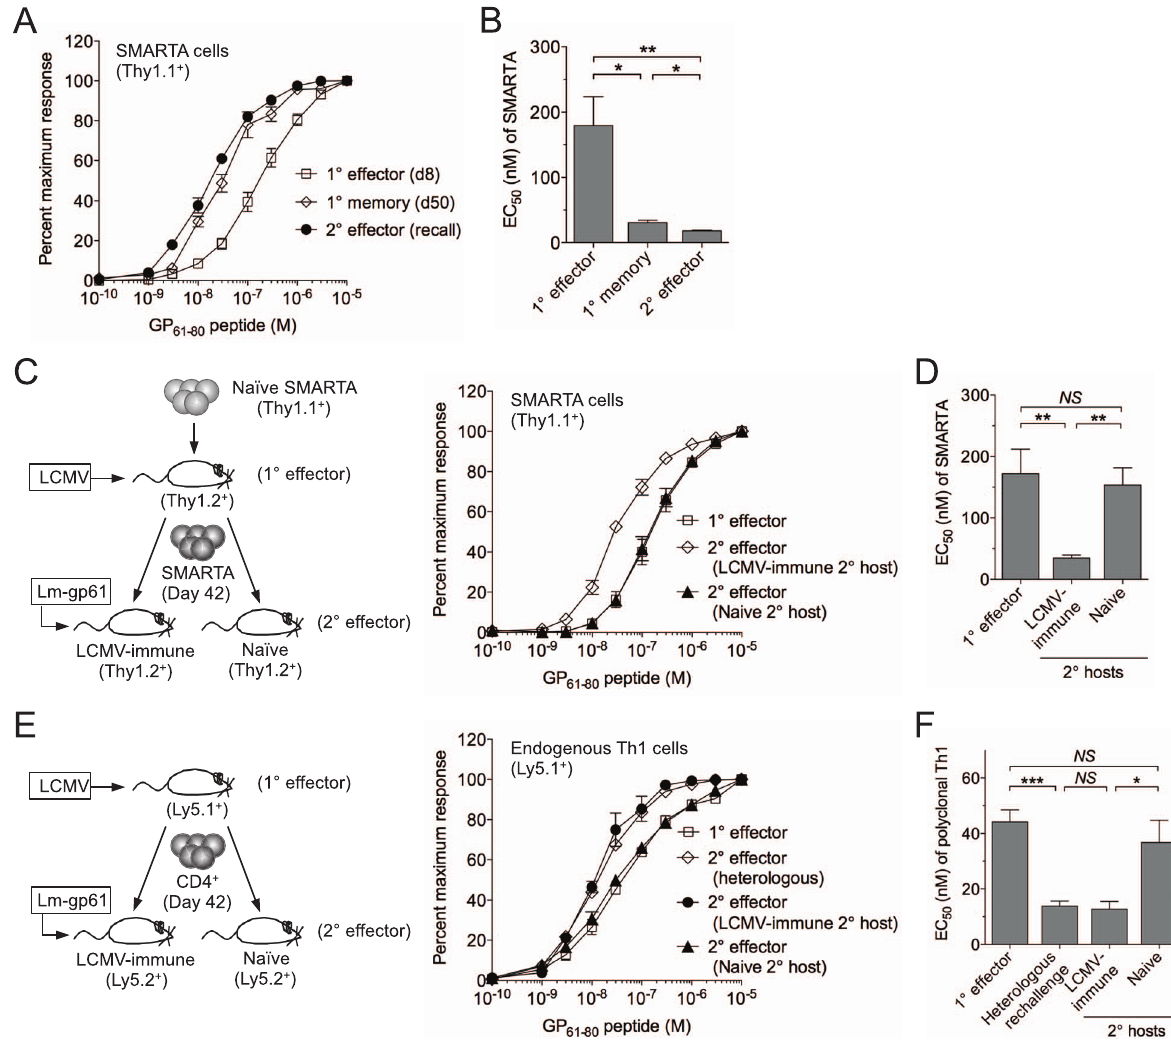
Figure 1. SMARTA memory cells lose functional avidity following heterologous rechallenge in naı¨ve but not immune hosts. 1 6 10 4 naı¨ve SMARTA cells (Thy1.1 + ) were transferred into naı¨ve B6 mice (Thy1.2 + ). A ) At day 50 post-infection mice were given a heterologous rechallenge with Lm-gp61. Splenocytes were harvested 7 days later and restimulated with GP 61-80 peptide in vitro for 4 hours in the presence of Brefeldin A, then permeabilized and stained for intracellular production of IFN c . Curves display the functional avidity of SMARTA cells in the spleen at the peak of the primary response (day 8), following the establishment of memory (day 50) and 7 days after secondary challenge with Lm-gp61 (recall), as determined by the percent maximum frequency of IFN c -producing SMARTA cells across the indicated range of peptide concentrations. B ) Bar graph displays the effective peptide concentration required for a half maximal response (EC 50 ), as determined by fitting the data to a sigmoidal curve (GraphPad Prism). C ) At day 50 post-infection, we isolated and transferred 1 6 10 4 SMARTA memory cells into naı¨ve or LCMV-immune (day 50 LCMV infection-matched) secondary hosts, followed by Lm-gp61 secondary challenge and splenocyte harvest at day 7. Graph displays functional avidity of Thy1.1 + SMARTA cells at day 7 post-rechallenge. D ) Bar graph indicates EC 50 for Thy1.1 + SMARTA cells at day 7 post-rechallenge. E ) We transferred 5 6 10 6 CD4 + T cells from LCMV-immune mice (day 42, CD45.1 + ) into naı¨ve or LCMV-immune secondary hosts (CD45.2 + ), followed by Lm-gp61 rechallenge. Graph shows functional avidity of CD4 + CD45.1 + IFN c -producing T cells in the spleen at the peak of the primary response, 7 days after rechallenge with Lm-gp61 (heterologous) or 7 days after rechallenge in naı¨ve or LCMV-immune secondary hosts. F ) Bar graph indicates EC 50 for CD4 + CD45.1 + IFN c -producing T cells for each group. Error bars indicate the standard error of the mean (SEM) (n=4–5 mice/group). Results are representative of three